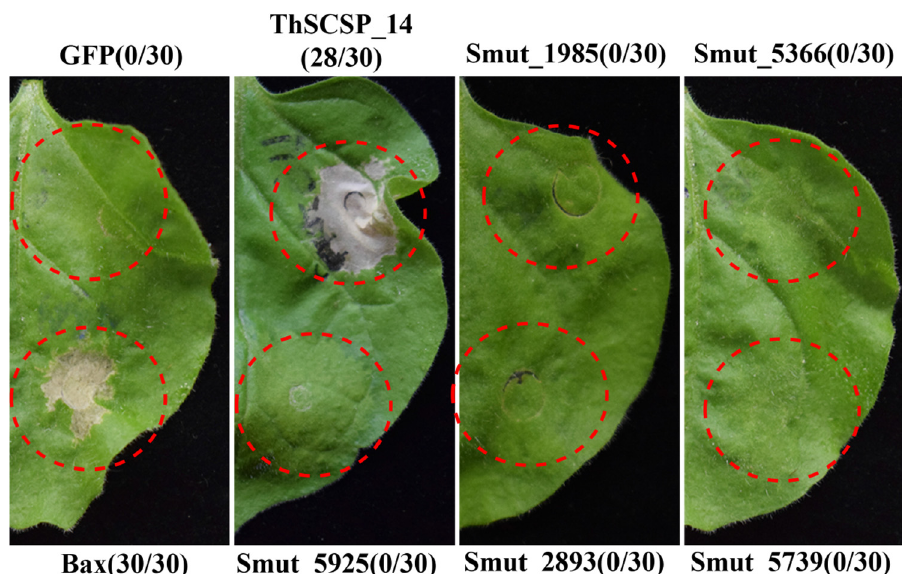
Figure 1. Putative effectors in Tilletia horrida trigger necrosis phenotype in epidermis cell of tobacco leaves. ThSCSP_14 and positive control BAX protein triggered cell death in epidermis cell of tobacco leaves; however, other five selected proteins and negative control green fluorescent protein (GFP) did not. The 30/30 denotes 30 of 30 infiltrated tobacco leaves exhibiting the necrosis phenotype. Representative photos were taken at 4 days post-infiltration (dpi).